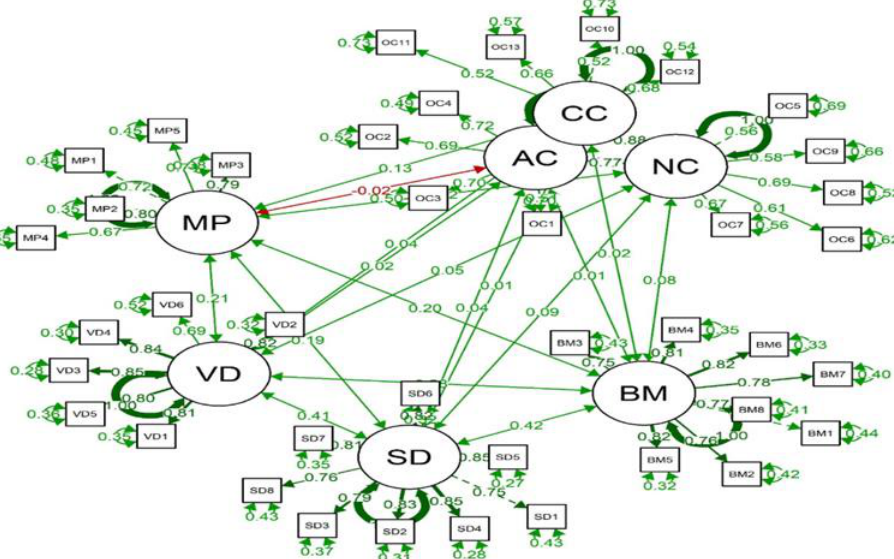
Figure 3. Measurement Model. Figure Legend: VD: Value Driven; SD: Self-Directed; BM: Boundaryless Mobility; MP: Mobility Preference; AC: Affective Commitment; NC: Normative Commitment; CC: Continuance Commitment. Table 3. Fit Indexes for the Measurement Model. Table 6. Estimates for the Parameters of the Model.